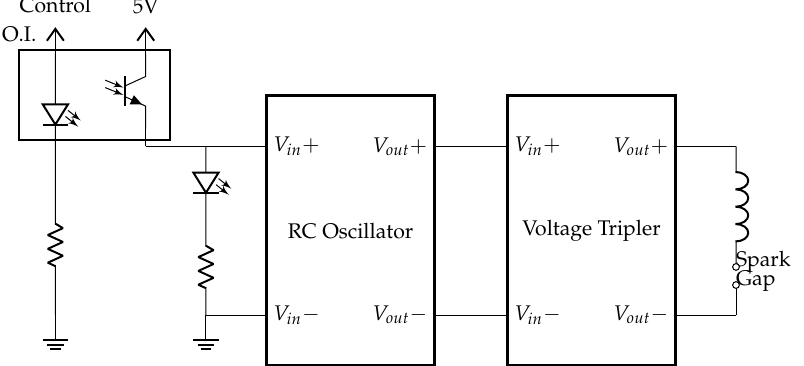
Figure 1. The EM fault injector. When a control signal is applied, the optic isolator (O.I) allows current flow to the oscillator, which feeds a voltage tripler. When a voltage sufficient to bridge the gap is reached, a high current and a magnetic field are generated in the coil.